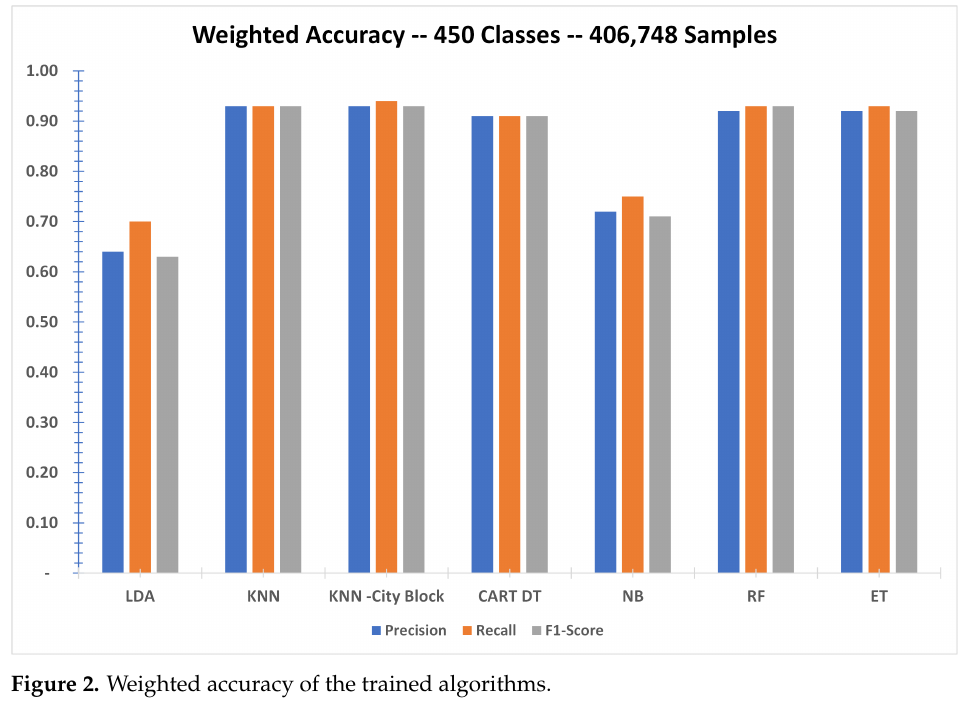
Figure 2. Weighted accuracy of the trained algorithms.